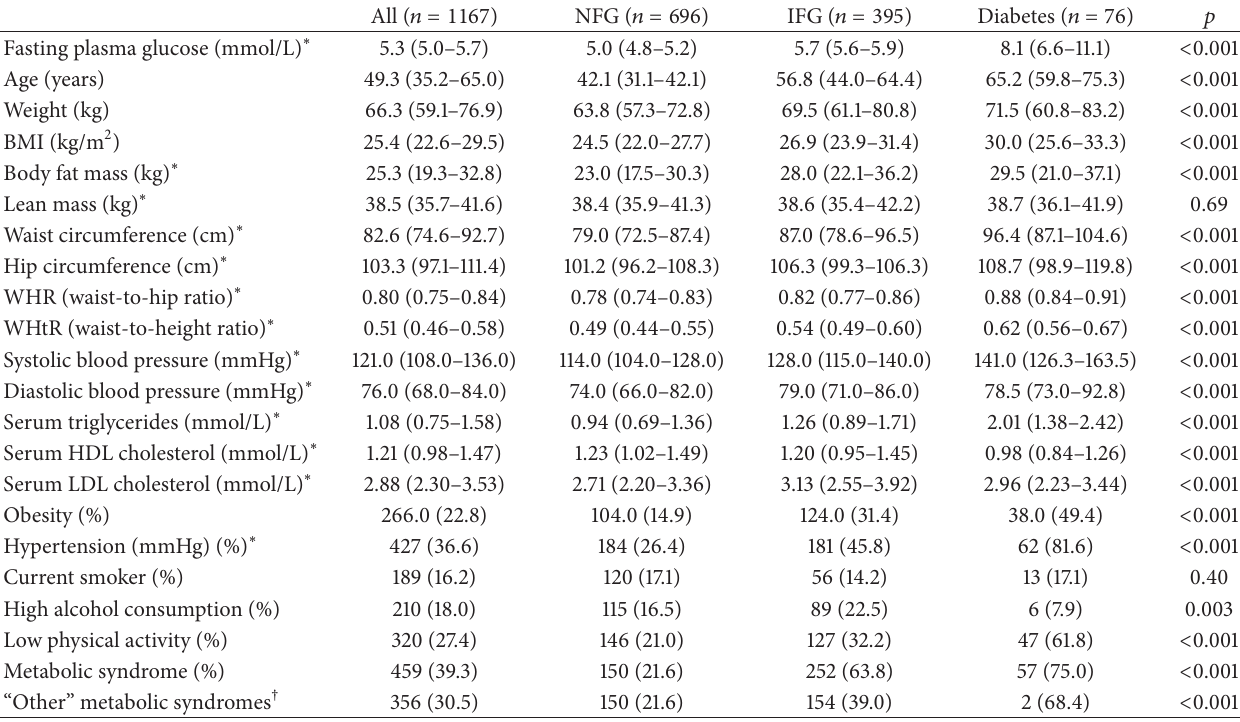
Table 1: Subject characteristics according to diabetes status at baseline (normal fasting glucose (NFG), impaired fasting glucose (IFG), and diabetes). Data are shown as median (interquartile range) or 𝑛